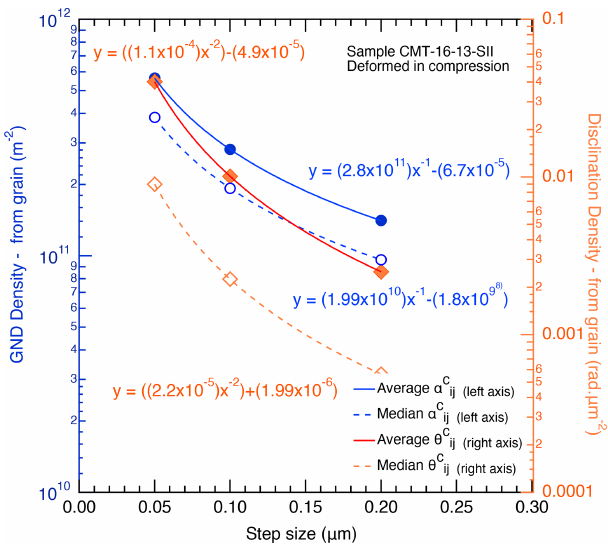
Figure 9. Resulting variation in average and median densities (from an one-point-per-grain data set) of GND and disclination densities as a function of the EBSD acquisition step size from 0.05µm (orig- inal step size) to 0.1µm (new sampling) and 0.2µm (as displayed in Fig.